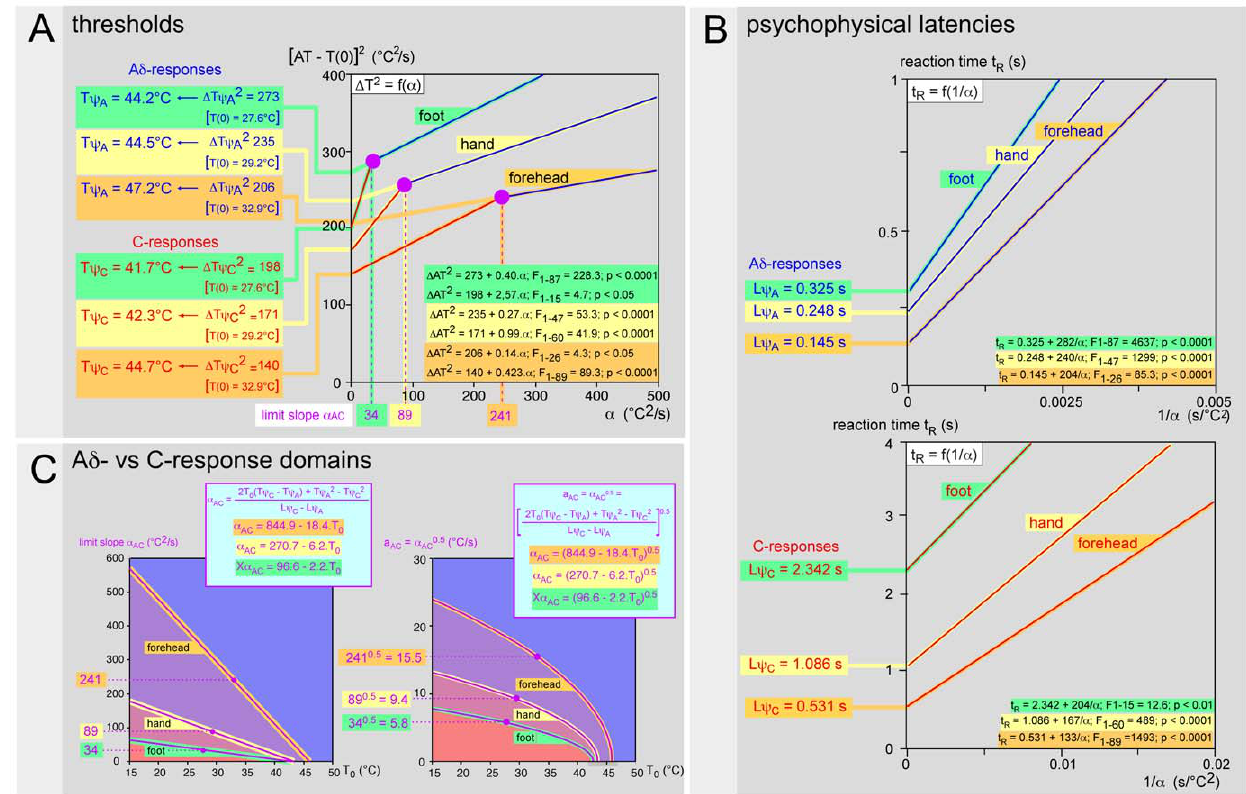
Figure 8. Influence of the part of the body stimulated on the limit slope a AC . Three physical territories, with different distances to the Central Nervous System, namely forehead, hand and foot, were stimulated. The results from an individual subject are shown. - A Relationship (AT 2 T 0 ) 2 =f( a ) allowing the determination of psychophysical thresholds T y and limit slopes a AC , marked by a dotted purple line. The highest thresholds were observed from the forehead and the limit slopes a AC were classified in the following order: foot , hand , forehead. - B Relationship t R =f(1/ a ) allowing the determination of the psychophysical latencies L y A (higher graph) and L y C (lower graph). They were classified in the following order: foot . hand . forehead. - C Curves which delimited in the plane [T 0 , a], the domains of obtaining responses triggered by A d - and C-fibers respectively (see Fig. 4); the purple full circles correspond to the values determined experimentally; curves are calculated from the T y C , T y A , L y C and L y A values, all determined experimentally. healthy volunteers and the overall results are summarized in lamp (shut off during recordings). In the individual example of figure 9E. It was confirmed by non-parametric statistics (Wil- figure 9A, one sees a downward shift of the two straight lines D AT 2 = f( a ) and a concomitant drop of the limit slope a AC